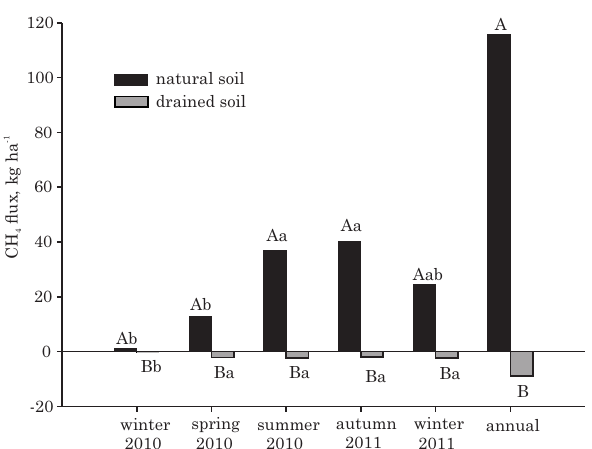
Figure 5. Seasonal and annual cumulative methane (CH 4 ) fluxes from natural and drained Histosols with waterlogged grassland vegetation. Capital letters indicate differences between the drainage level of the soil in the same season and the annual sum; lowercase letters indicate differences between seasons in the same soil drainage condition, by Tukey’s test (p<0.05). The first two bars refer only to the end of winter